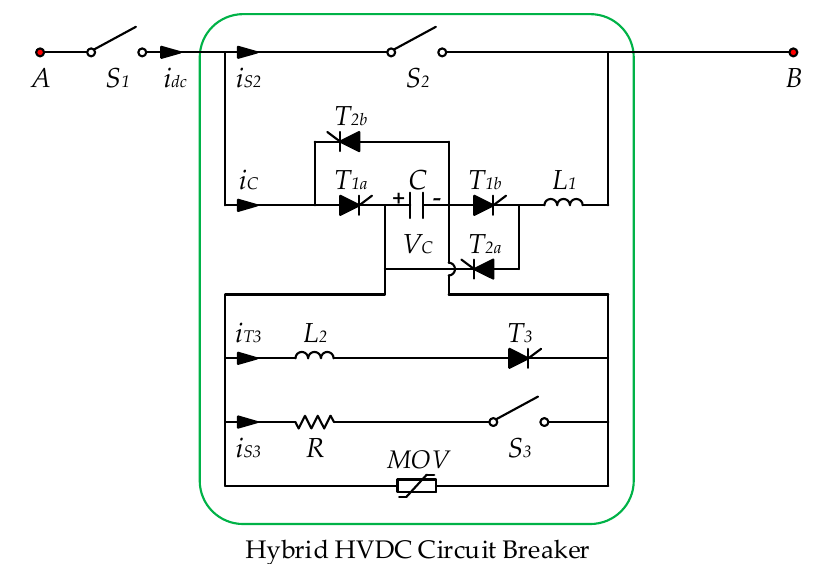
Figure 1. The proposed bidirectional hybrid circuit breaker (HCB) topology.